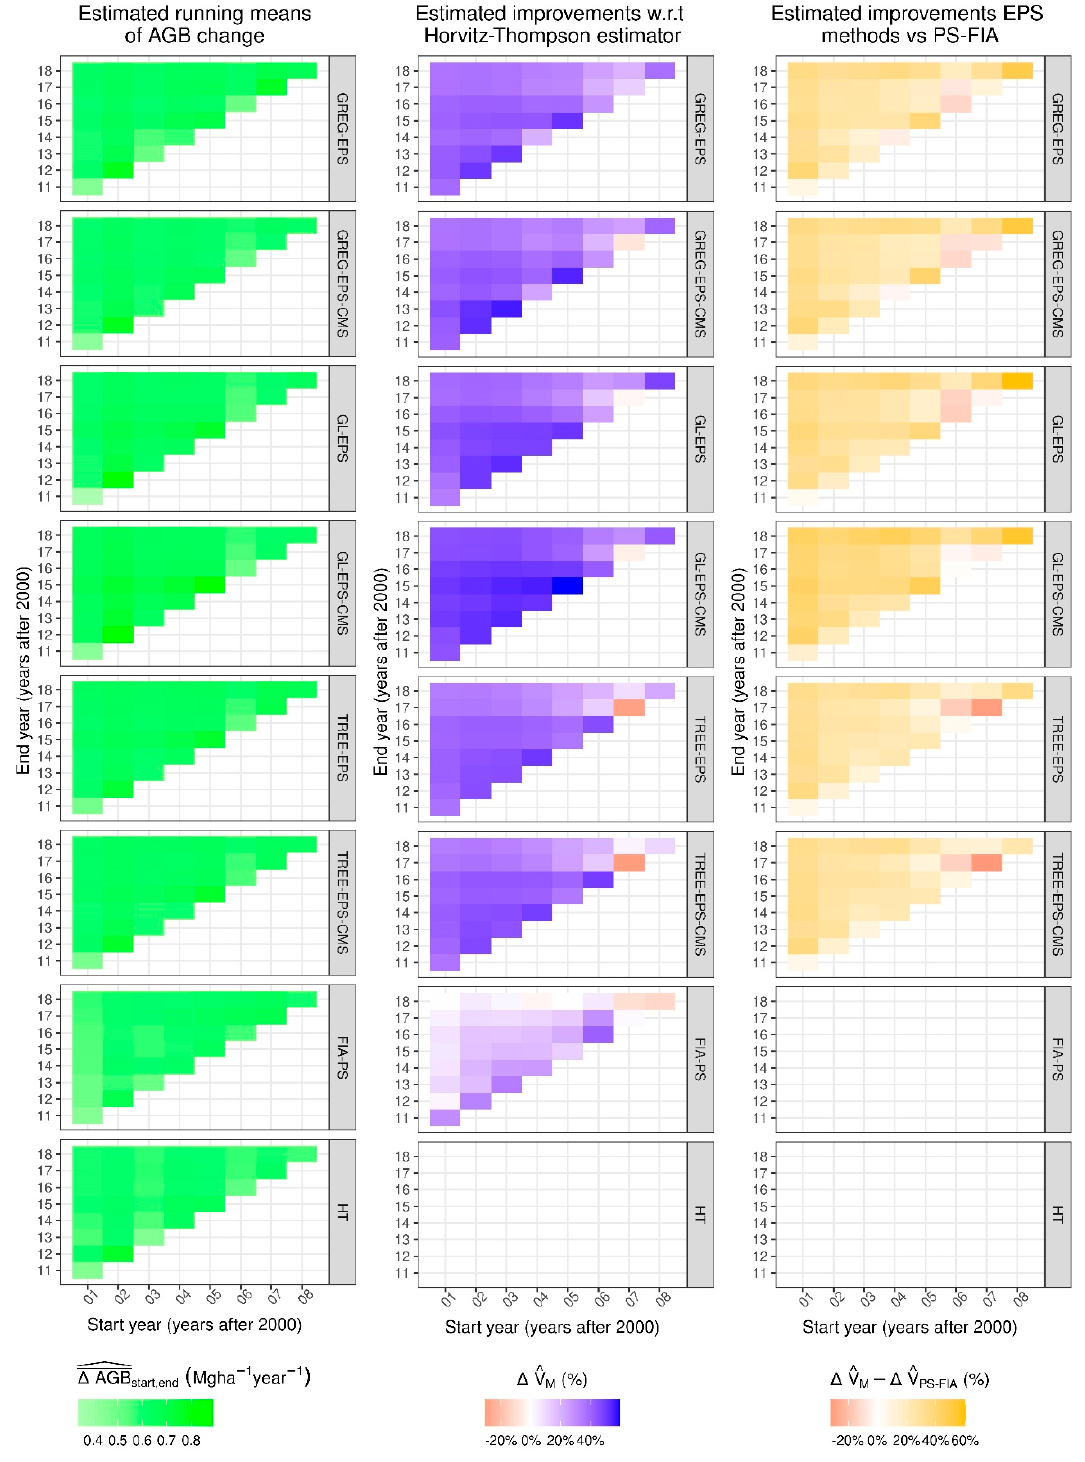
Figure 6. Estimated change for all periods considered in the study ( left ). Estimated improvements with respect to the Horvitz-Thompson estimator ( middle ) and estimated improvements of endoge- nous poststratification methods with respect to the poststratification currently used ( right ). Note that single 10-year periods appear in the diagonal.